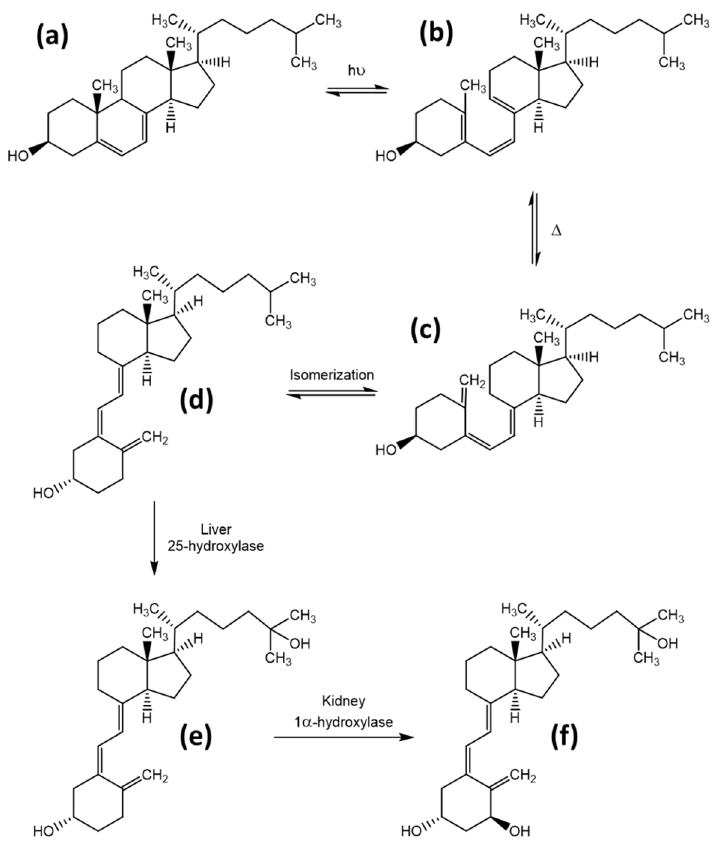
Figure 3. Synthesis pathway of the active hormonal form 1,25(OH) 2 D 3 from 7-dehydrocholesterol. Breakage of the 9,10-bond within the B-ring of 7-dehydrocholesterol ( a ) by ultraviolet radiation forms previtamin D 3 ( b ). The ring opening is followed by a rapid, thermally induced isomerisation by a [1,7]-hydrogen atom shift ( c ), followed by a spontaneous shift from the 6- cis -conformer to the 6- trans -conformer, resulting in vitamin D 3 ( d ). These three reaction steps occur spontaneously without any enzyme catalysis, but at a low efficacy in the body. Hydroxylation at position C25 by 25-hydroxylase in the liver to 25(OH)D 3 ( e ), and a second hydroxylation by 25(OH)D-1-hydroxylase in the kidney results in the active hormonal form, 1,25(OH) 2 D 3 ( f ). The 1,25(OH) 2 D 3 exerts its action by binding to the VDR. VDR is the only